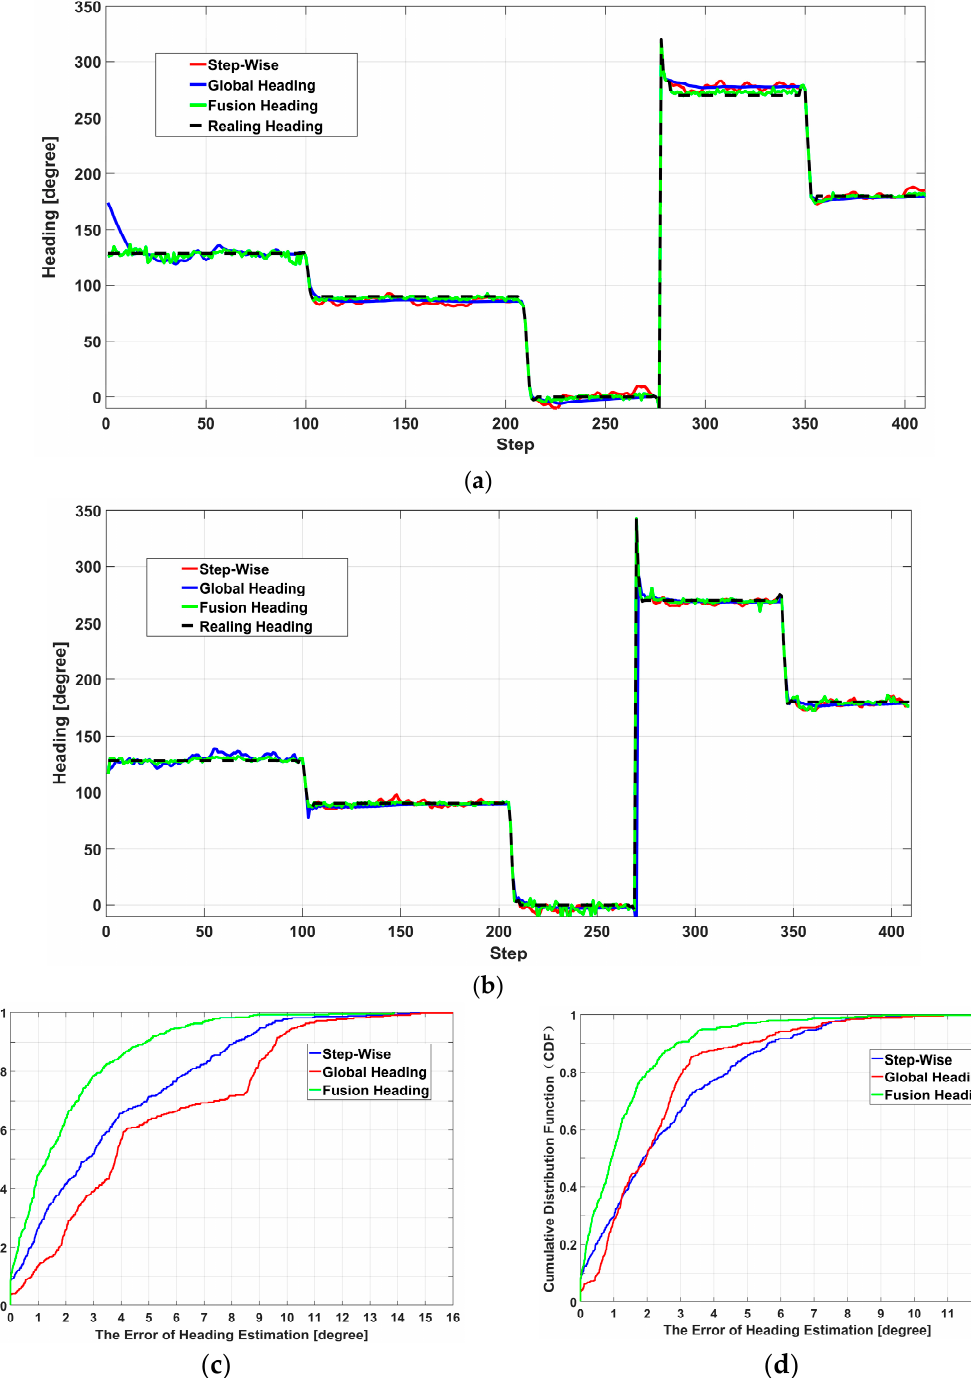
Figure 12. Results of heading estimation for different heading estimation methods; ( a ) the results of the heading estimation in holding mode; ( b ) the results of the heading estimation in pocket mode; ( c ) a comparison of the cumulative distribution of errors for different heading estimation methods in holding mode; ( d ) a comparison of the cumulative distribution of errors for different heading estimation methods in pocket mode.